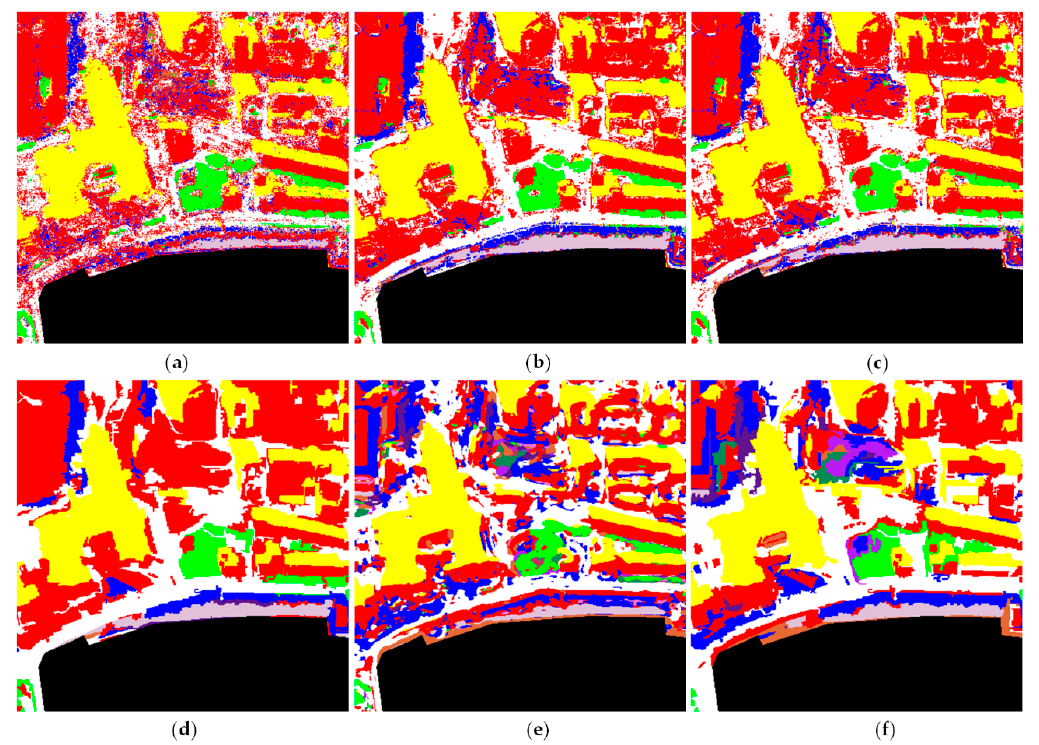
Figure 10. Local details of the classification results in bathing beach area. ( a ) Raw; ( b ) SS; ( c ) OSS; ( d ) OSS-MSSC; ( e ) VGG; ( f ) VGG-MSS.